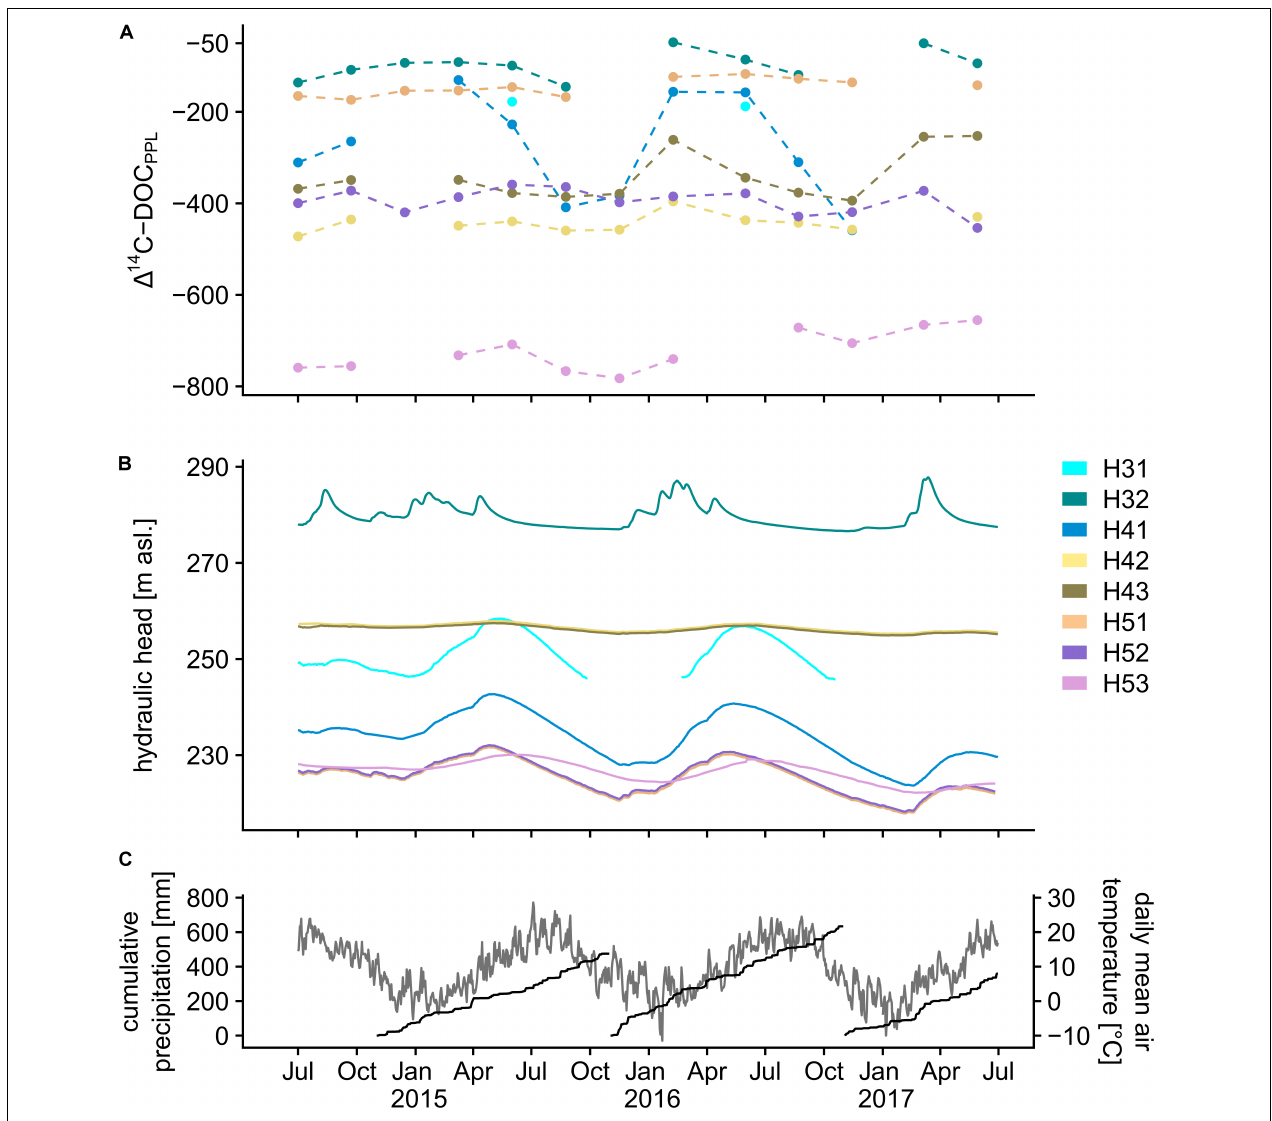
FIGURE 5 | Combined graph highlighting the connection of the 14 C depletion of SPE-DOM and the hydraulic pressure layout of the Hainich Critical Zone aquifers over three consecutive years. (A) (cid:49) 14 C in SPE-DOM. Missing values resulted from either non-productive wells during the time of sampling or measurement failure. (B) Hydraulic head configuration. (C) Cumulative 12-monthly precipitation and daily mean air temperature recorded by the meteorological station in Weberstedt (MeteoGroup Deutschland GmbH, Germany; 270 m